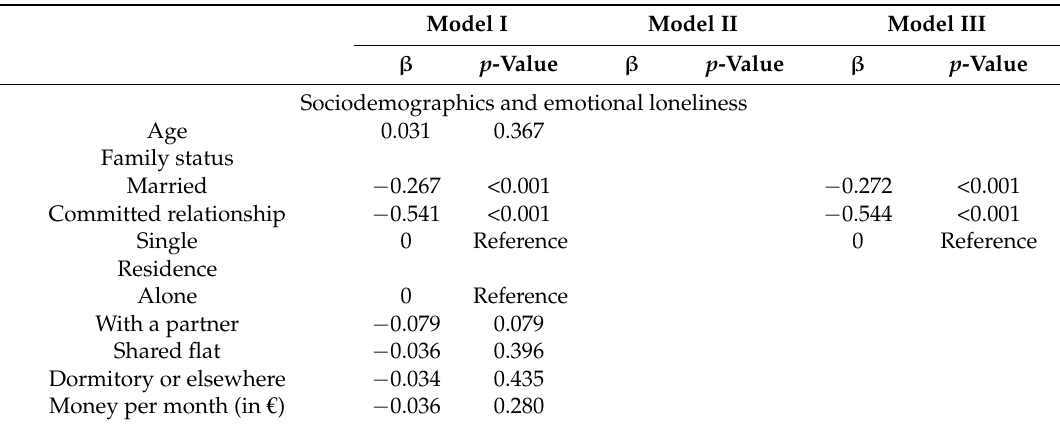
Table 4. Regression on emotional loneliness in university students in